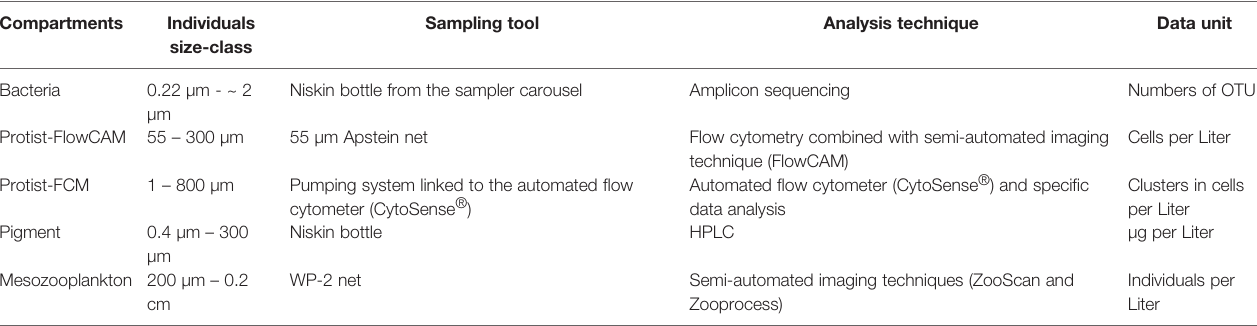
TABLE 2 | The fi ve biotic plankton compartments with their respective sampled size-classes, sampling tool, analysis techniques, and fi nal data units produced. Compartments